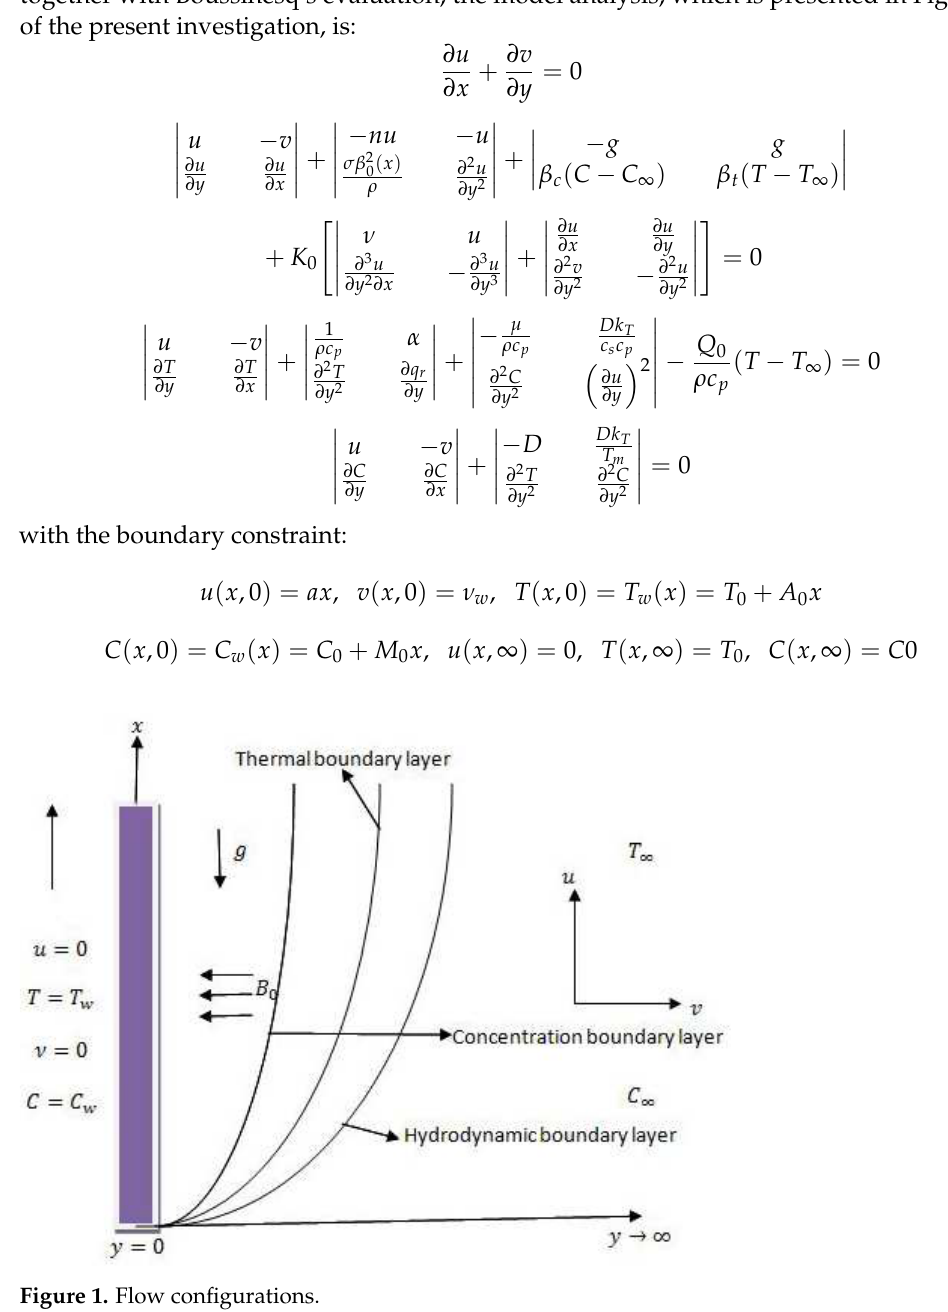
Figure 1. Flow configurations.